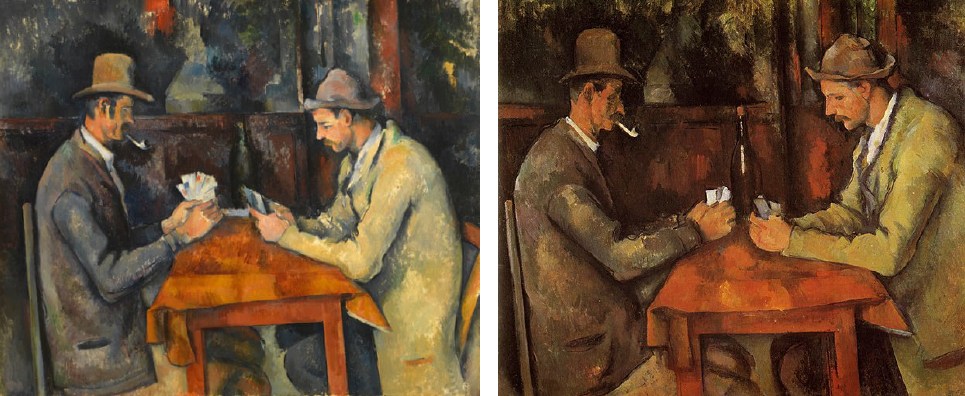
Figure 4: Paul Cźanne, The Card Players , oil on